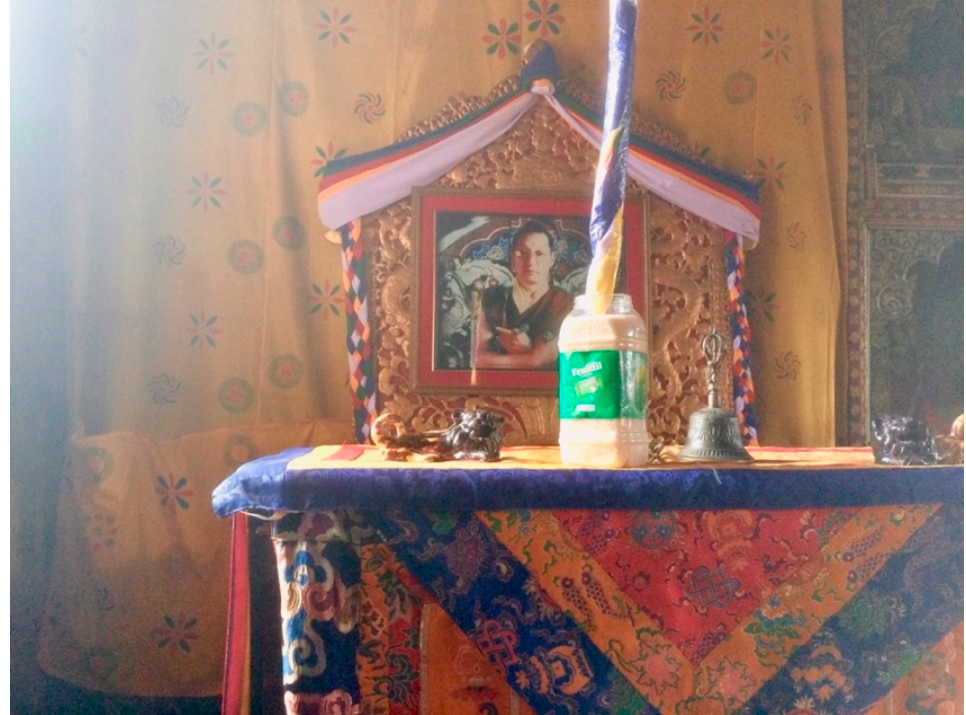
Figure 5. An image of Gangteng Tulku Rinpoche, the Buddhist teacher who founded Gangteng Monastery in Bhutan, who is also the teacher who administered Shin Yu Pai’s vows of refuge in 1998. Photograph by the Shin Yu Pai.